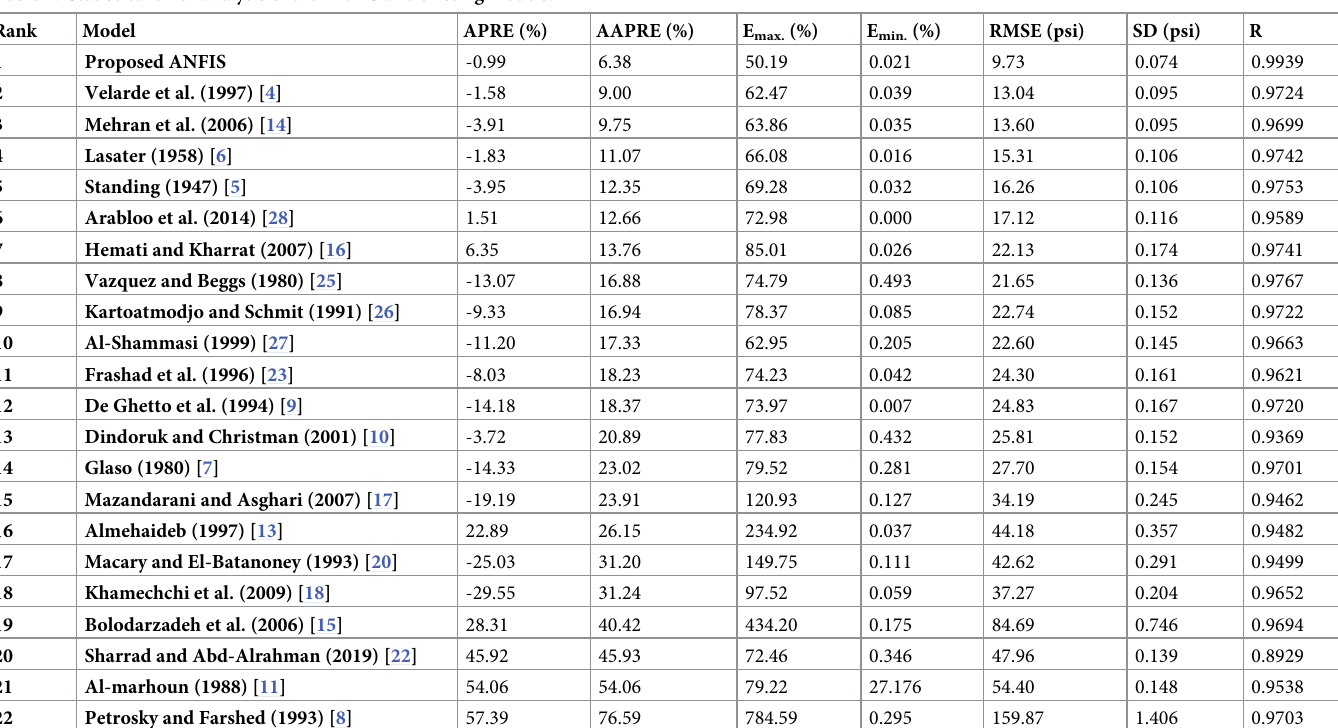
Table 4. Statistical error analysis of the ANFIS and existing